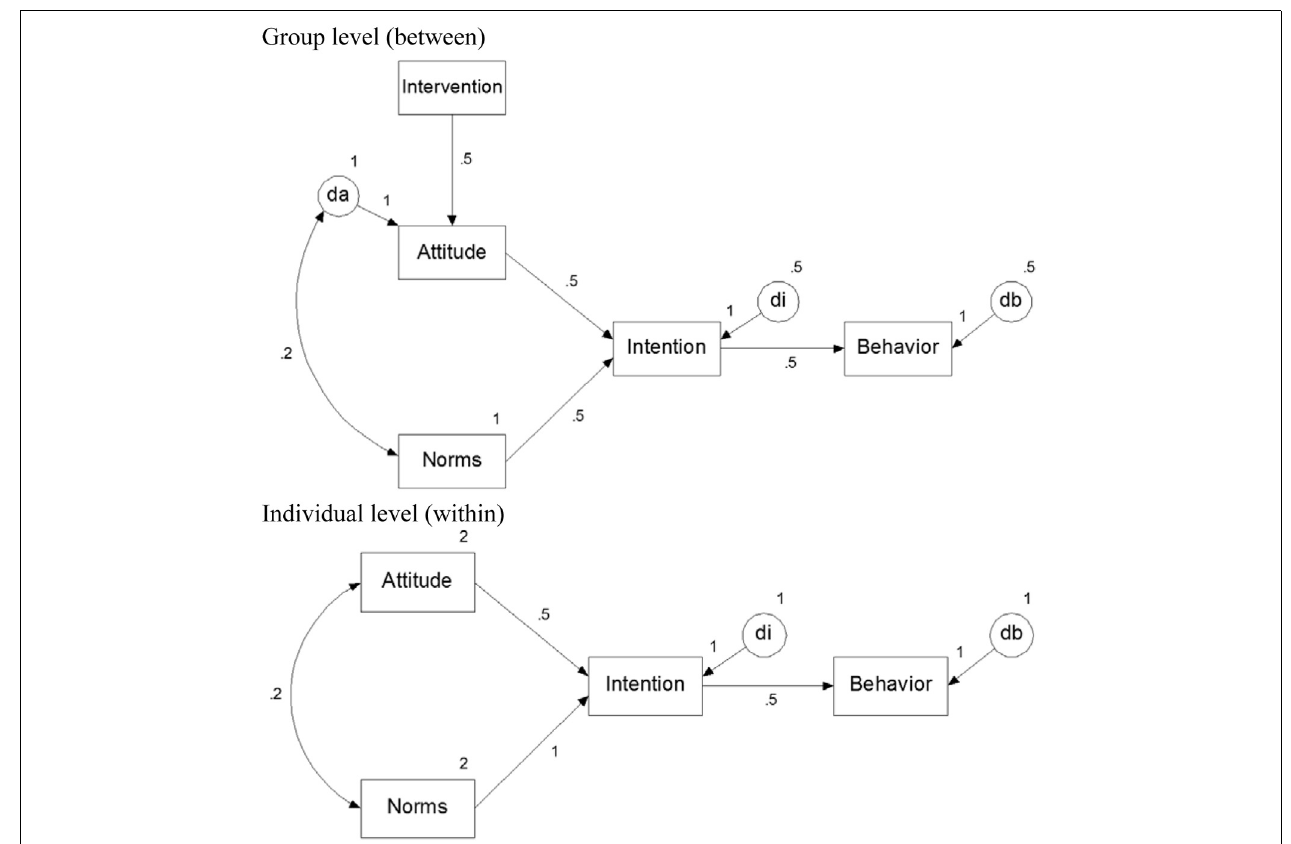
FIGURE A1 | The planned behavior model at the between-cluster level (Top panel) and within-cluster level (Bottom panel) with population parameter values.